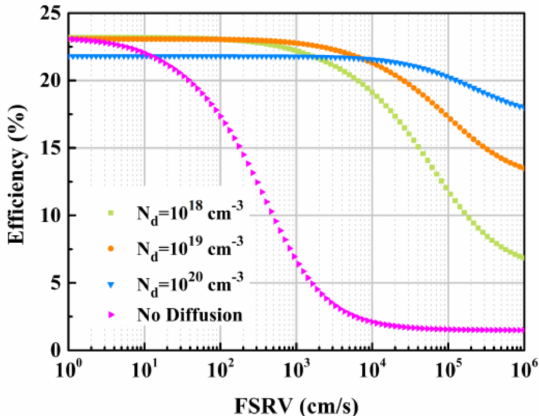
Figure 3. E ffi ciencies of the simulated IBC solar cells as a function of the front surface recombination velocity (FSRV). N d indicates the front surface layer doping concentration. The e ffi ciencies of the undoped front surface control samples are shown in magenta. Each doping junction depth was fixed at 0.67 µ m and the lines are guides for the